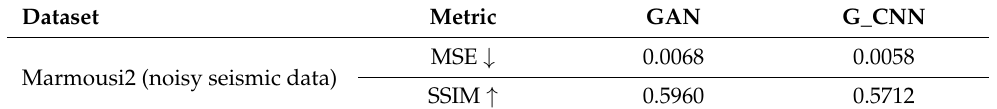
Table 4. Results of the experiments on the Marmousi2 dataset with noisy seismic data with the two neural network models. The metrics were obtained by comparing the test data and the result generated by each network. The symbol ↓ indicates that the smaller the value, the better the result, while ↑ indicates that the bigger the value, the better the result.